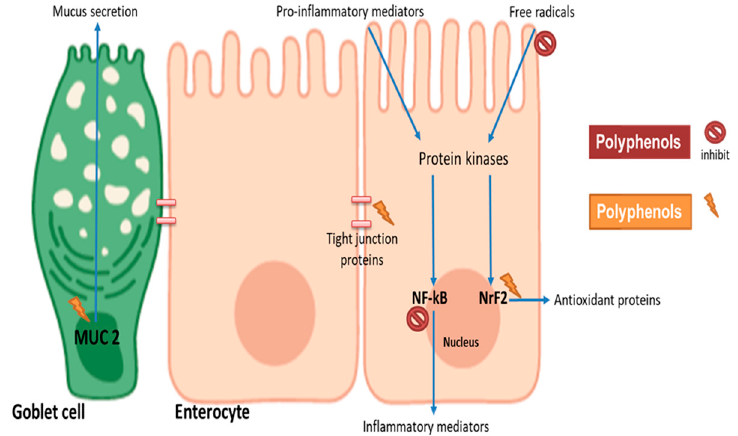
Figure 2. Potential mechanisms involved in polyphenol modulation of intestinal barrier function. Cereal polyphenols may attenuate pro-inflammatory and oxidative stress-induced barrier dysfunction by inhibiting NF-kB and stimulating Nrf2, respectively. Polyphenols may induce the expression of tight junction proteins to enhance barrier integrity. Mucin gene (MUC2) upregulation in goblet cells provides physical layer protection. The figure was created with BioRender.com.